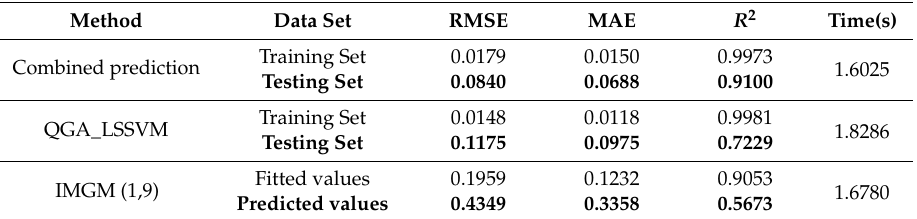
Table 9. The forecasting evaluation indexes of the vibration signal.